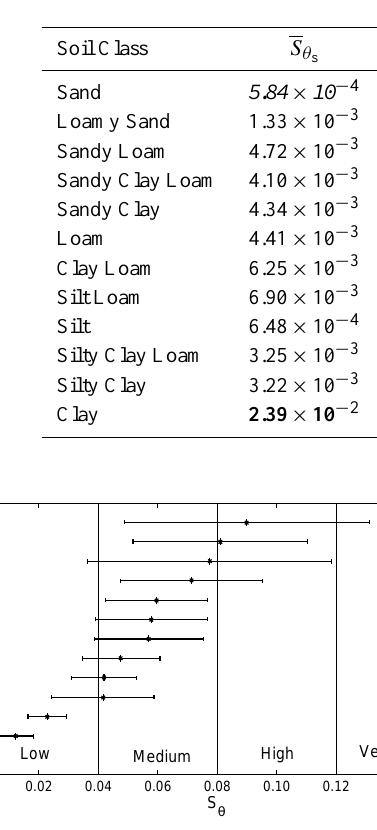
Table 2. Average sensitivity index within the USDA soil classes, for the different soil hydraulic parameters; the class with the highest average sensitivity is indicated in boldface, whereas the class with the lowest average sensitivity is in italics.